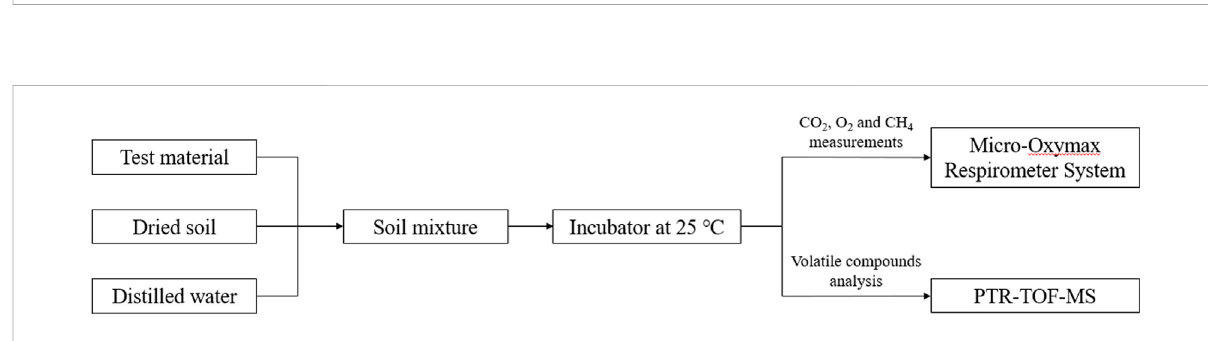
FIGURE 3 Flow chart of the biodegradability test and volatile compounds analysis. Test plastic (or reference material) and dried soil were mixed homogeneously with the supplement of distilled water. The soil mixture was incubated in a low temperature incubator with a constant temperature of 25 ° C. The changes of CO 2 , O 2 and CH 4 concentrations were measured by a Micro-Oxymax Respirometer System in real time and the volatile compounds were analyzed using a PTR-TOF-MS.